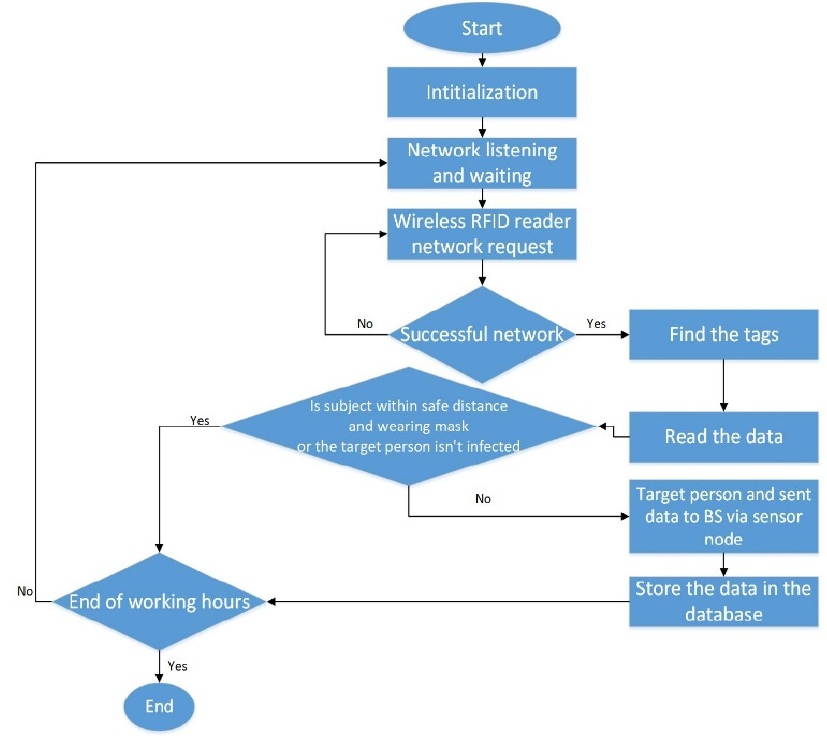
Figure 2. Proposed tracking system model flowchart.